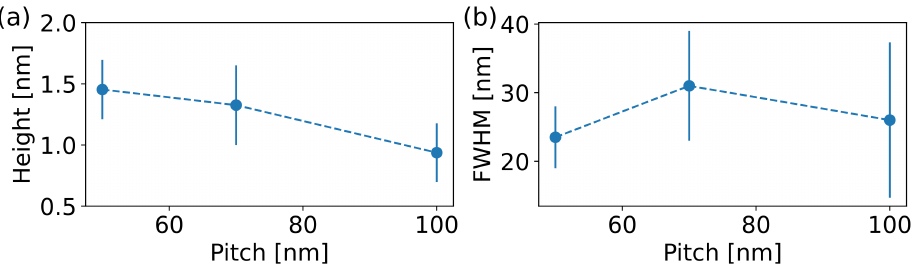
Figure 3. ( a ) Average height of the peaks measured via AFM as a function of the pitch p . ( b ) Average FWHM of the peaks measured via AFM as a function of the pitch p . Standard deviations are used as error